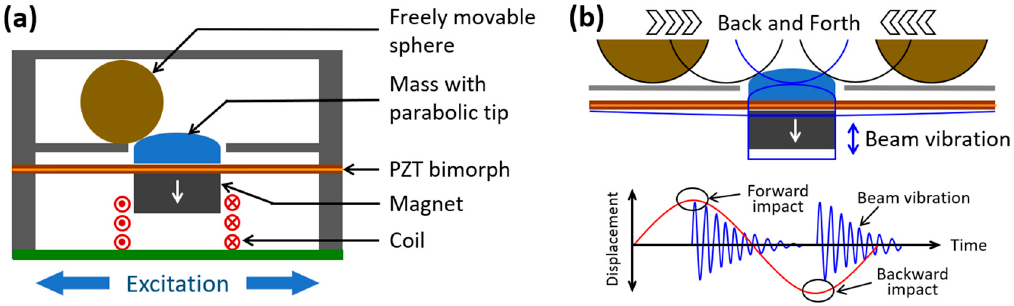
Figure 1. Schematics of the proposed transverse-impact driven frequency up-converted hybrid energy harvester ( a ) and its operation principle ( b ).